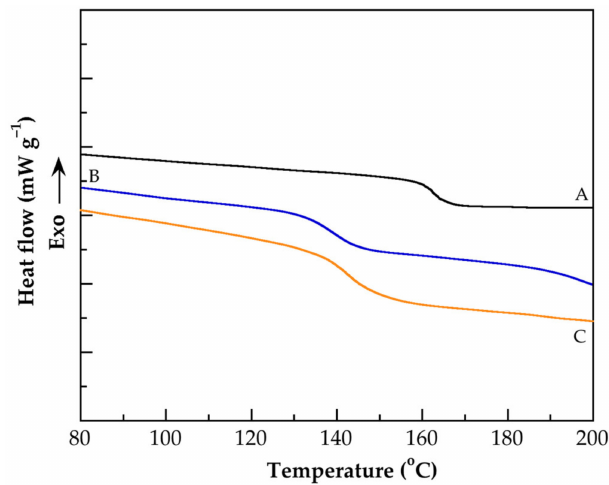
Figure 11. DSC thermograms of PMAA 2 ( A ), and of their nanocomposites: PMAA-G 3.0 -CNTs 3 ( B ) and PMAA-G 3.0 -CNTs 4 ( C ).